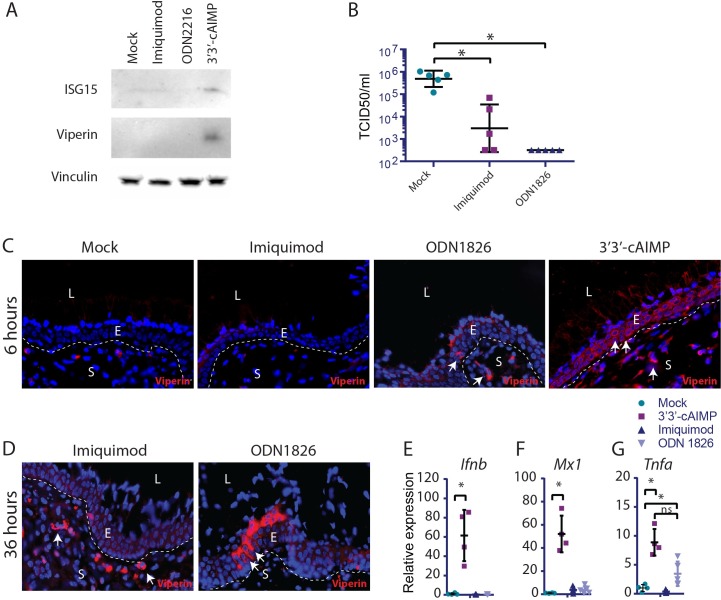
STING agonists induce IFN responses in the vaginal epithelium faster and more efficiently than TLR agonists.(A) HaCaT cells were treated with imiquimod (1μg/ ml), ODN2216 (1μg/ ml), and 3’3’-cAIMP (100μg/ ml) for 24 h. Levels of ISG15 and viperin were determined in the cell lysate by Western blotting. (B) Mice were treated intravaginally with imiquimod or ODN1826 (25 μg per mouse) 12 h prior to infection with HSV2. Vaginal washes were collected 48 h p.i. and viral load was determined. n = 5 per group. (C-D) Mice were anesthetized for 30 min and imiquimod, ODN1826, or 3’3’-cAIMP was applied to the vagina. Tissues were isolated (C) 6 h or (D) 36 h after treatment. Paraffin sections of the vaginal tissues were stained for viperin (red). DAPI (blue) marks the nuclei and the dotted white lines mark basal membrane between the epithelium and stroma. White arrows highlight examples of viperin positive cells. L = lumen, E = epithelium, S = stroma. n = 4. One representative picture is shown for each staining. (E-G) RNA was isolated from vaginal tissue treated as indicated for 6 h, and levels of Ifnb, Mx1, and Tnfa mRNA were determined by RT-qPCR. n = 4–5. mRNA levels were normalized to Gapdh and shown as relative levels of expression compared to mock-treated mice. (B, E-G) Statistics, Kruskal-Wallis test with Dunn’s multiple comparisons test. * = p<0,05 compared to mock treated.